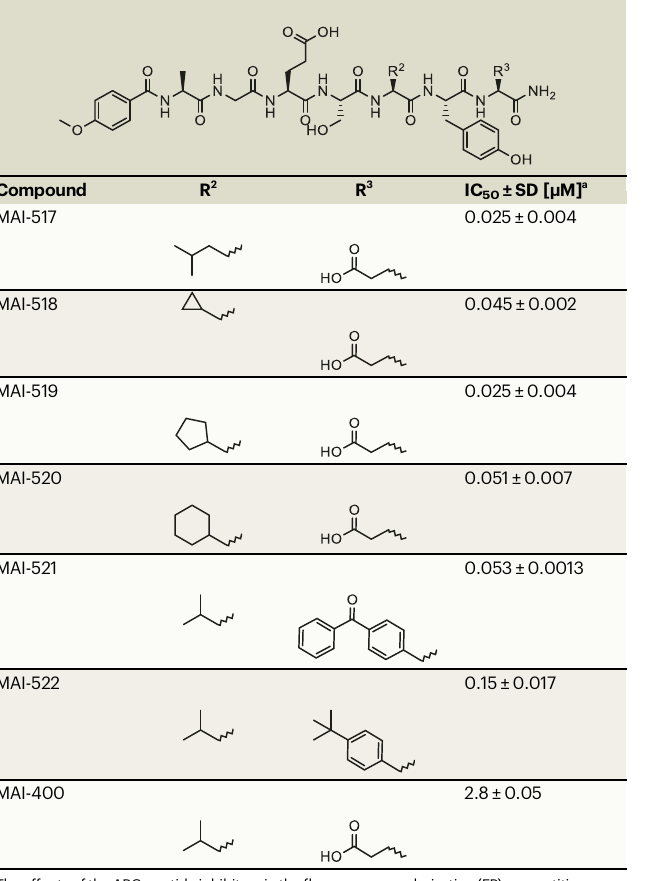
Table 5 | Kinetic parameters of MAI-203 and MAI-516 binding to APC as measured by SPR experiments Compound